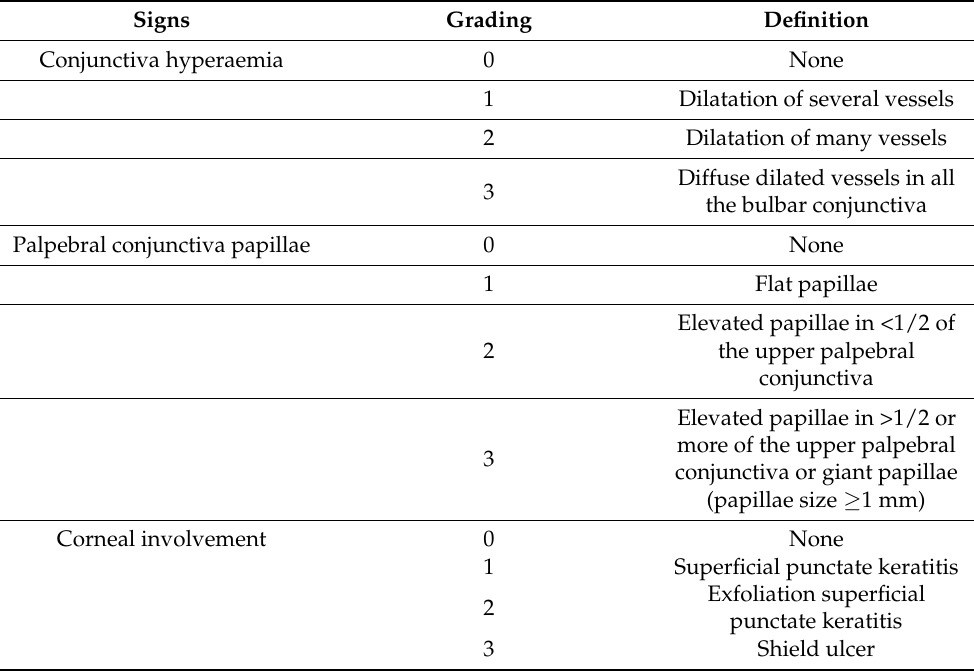
Table 1. Grading scales for clinical